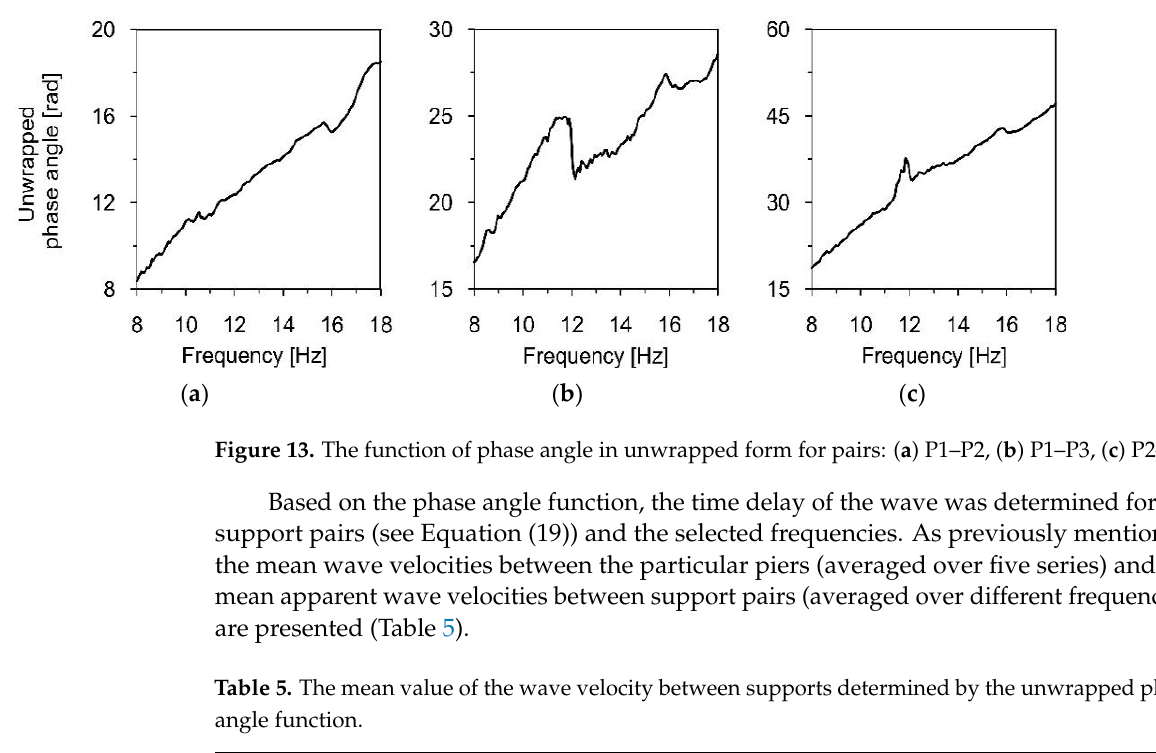
Figure 12. The function of phase angle in wrapped form for pairs: ( a ) P1 – P2, ( b ) P1 – P3, ( c ) P2 – P3.